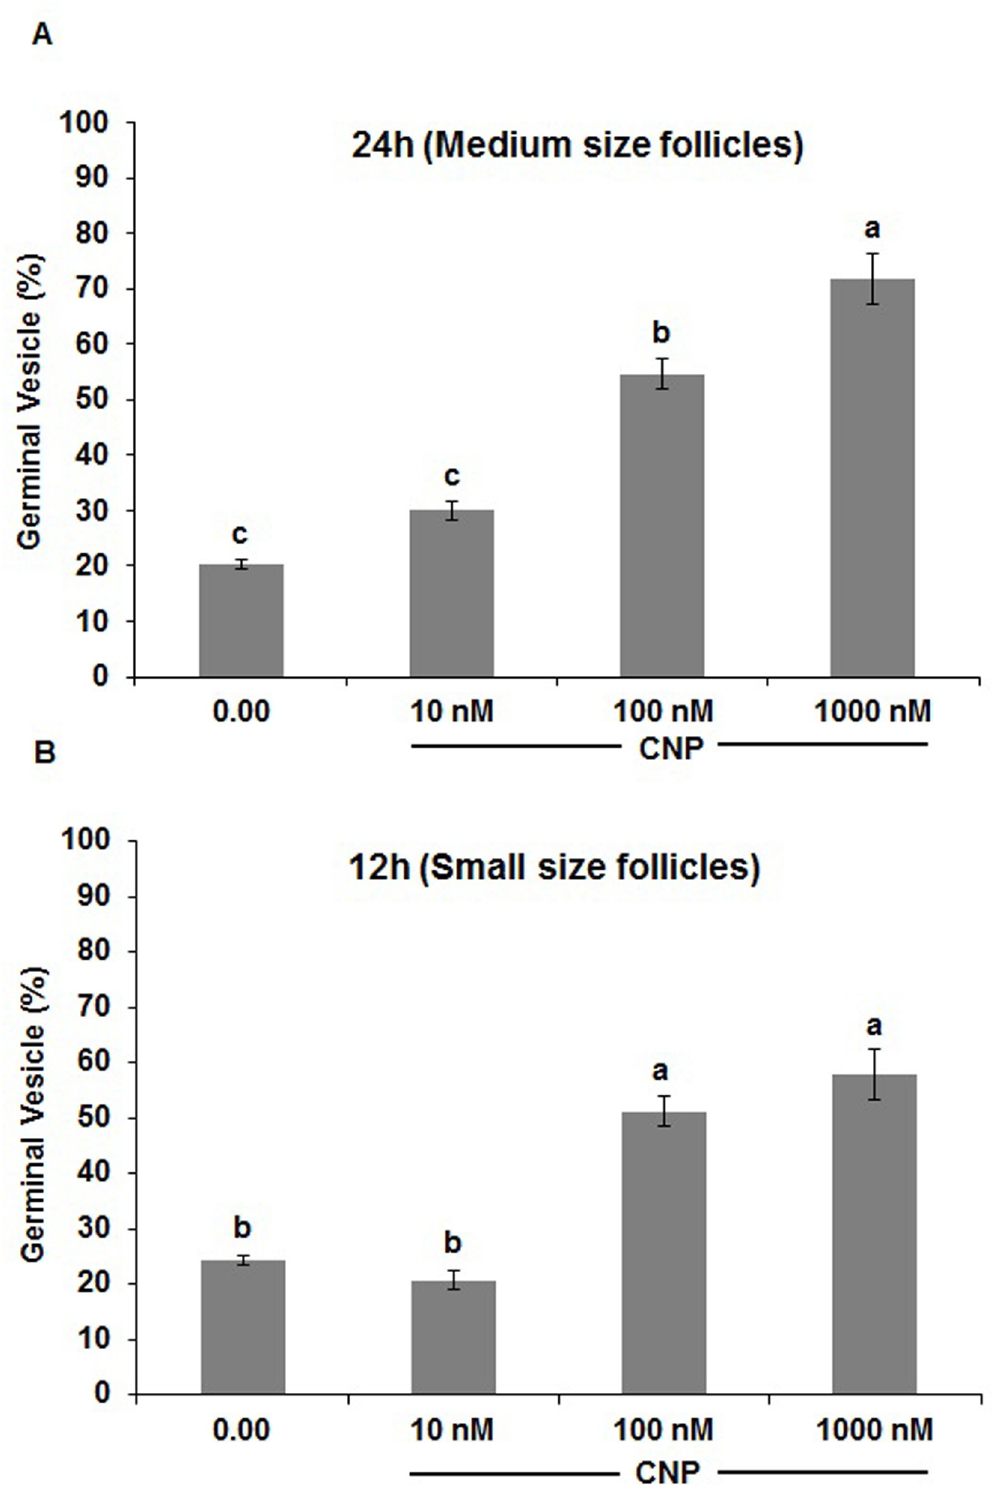
Fig 4. Determination of optimal concentration of CNP between oocytes derived from medium ( > 4 to 6 mm) and small (2 to � 4 mm) size follicles. 3 replicates and the minimum number of oocytes in each replicate were 30. Different superscripts demonstrate significant differences (P < 0.05). CNP: natriuretic peptide type C.